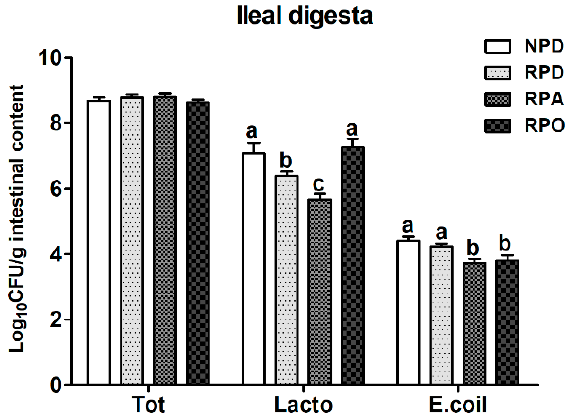
Figure 1. Influences of inclusion of oregano essential oil in a low-protein diet on intestinal microbiota of growing-finishing pigs. a,b Letters within a row indicate dramatical differences among means ( p < 0.05). 1 Values represent the mean of 6 pigs during the trial. 2 NPD = normal protein group; RPD = reduced protein, amino acid-supplemented group; RPA = 150 mg/kg chlortetracycline group; RPO = oregano essential oil (250 mg/kg) group; E. coli = Escherichia coli.